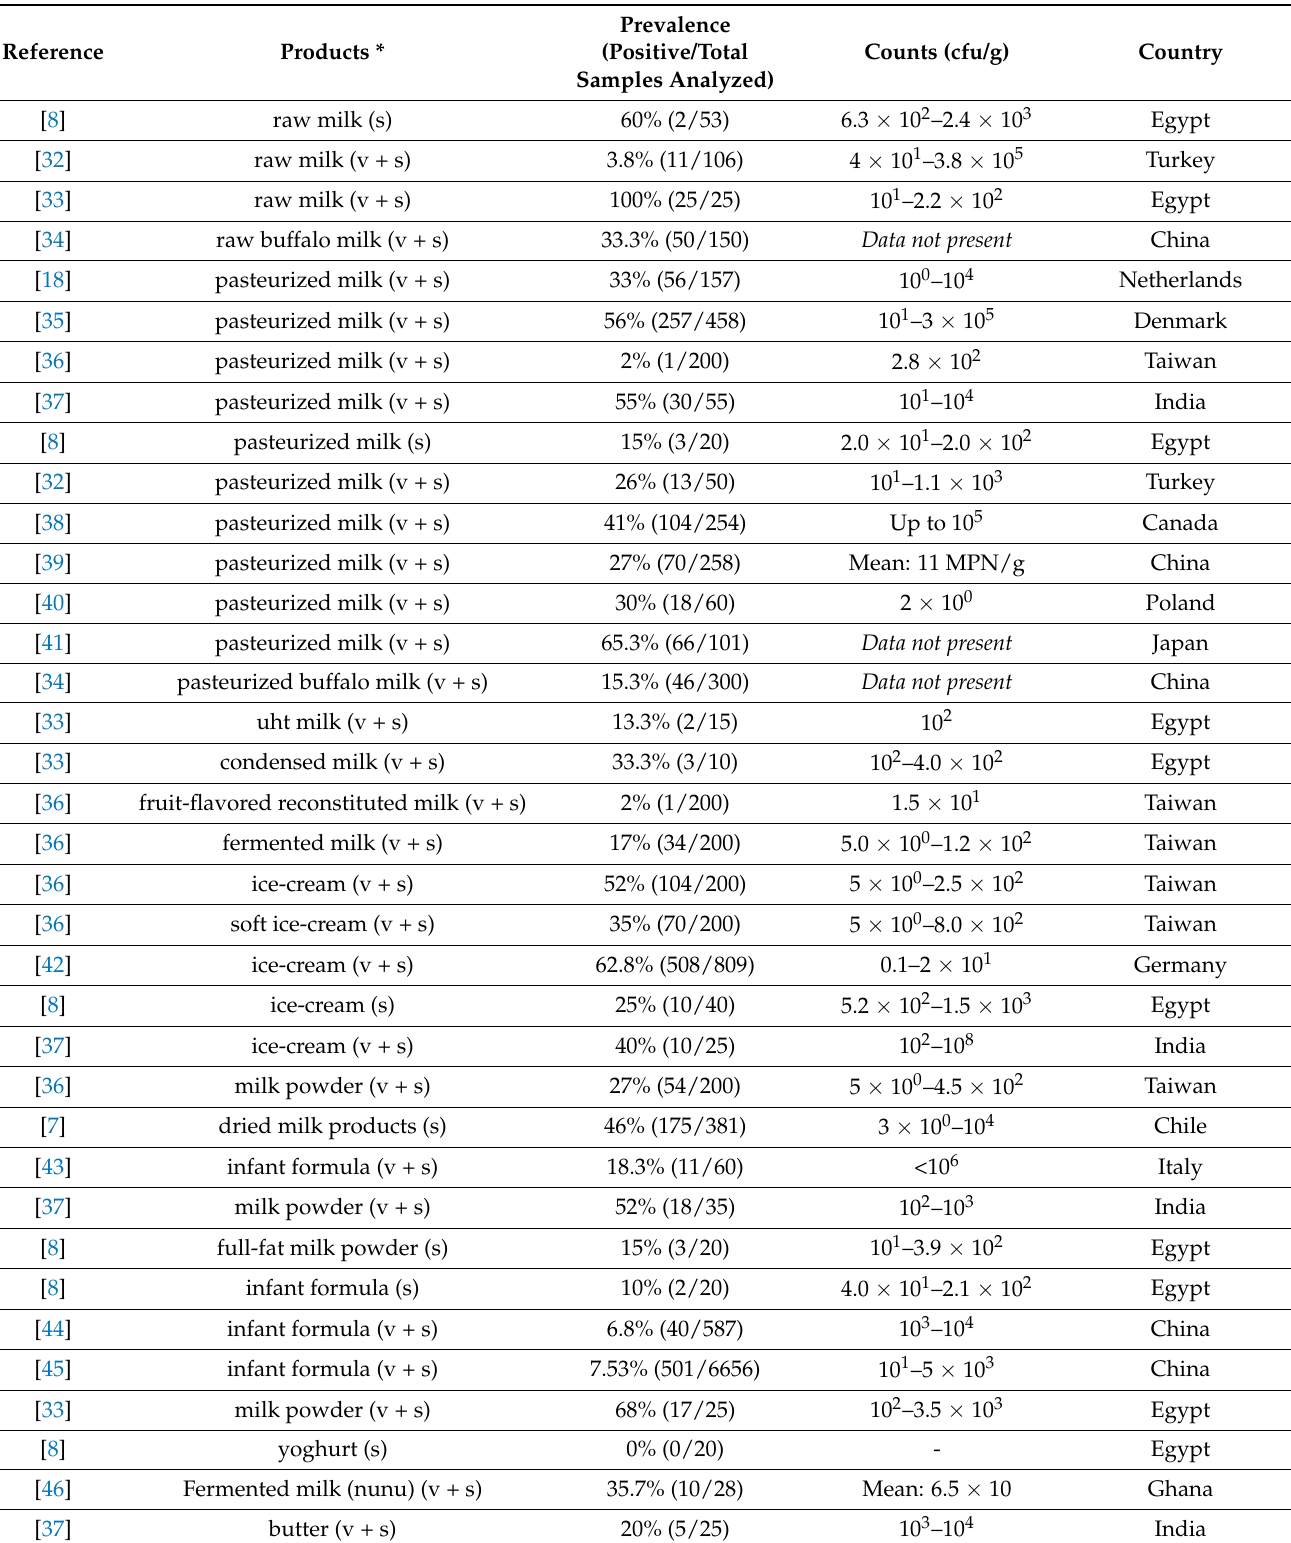
Table 2. Prevalence and concentrations of B. cereus in milk and milk products reported in previous studies